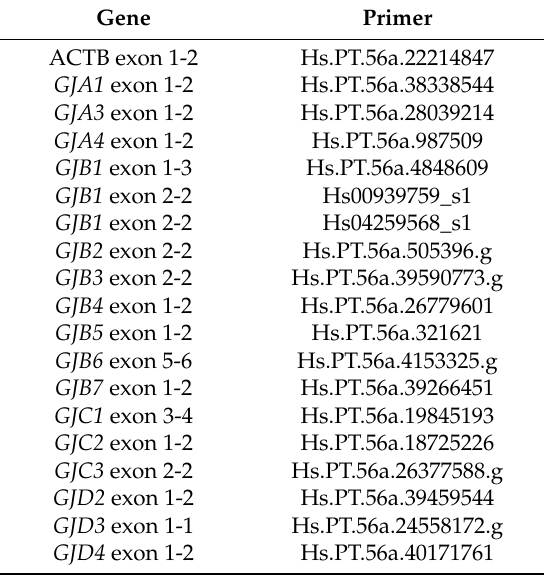
Table 4. Predesigned primers used for qRT-PCR testing of connexin target exons. Gene Primer ACTB exon